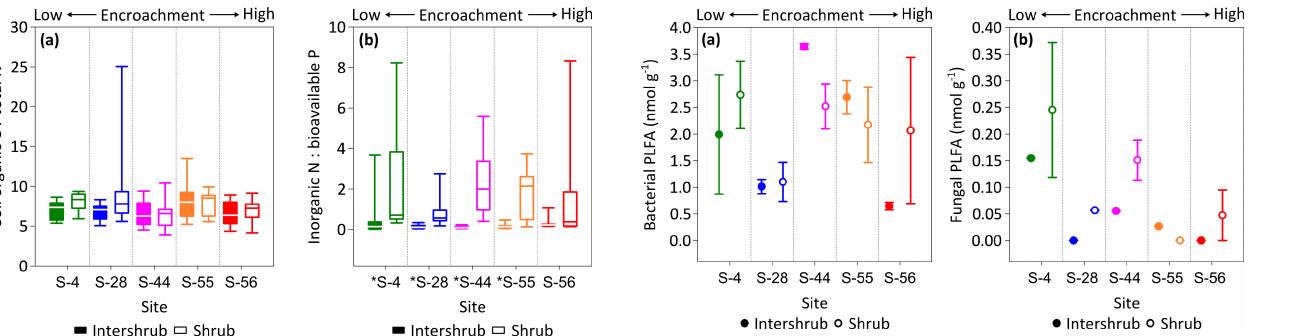
Figure 7. SOC:total N (a) and inorganic N:bioavailable P (b) ra- tios for surface soil (top 10cm) under inter-shrub and shrub cover types along a shrub encroachment gradient in the Santa Rita Ex- perimental Range, AZ, US ( n = 9). Inter-shrub and shrub soils at sites denoted with an asterisk differ significantly from each other at p <0.05 (Mann–Whitney U test).